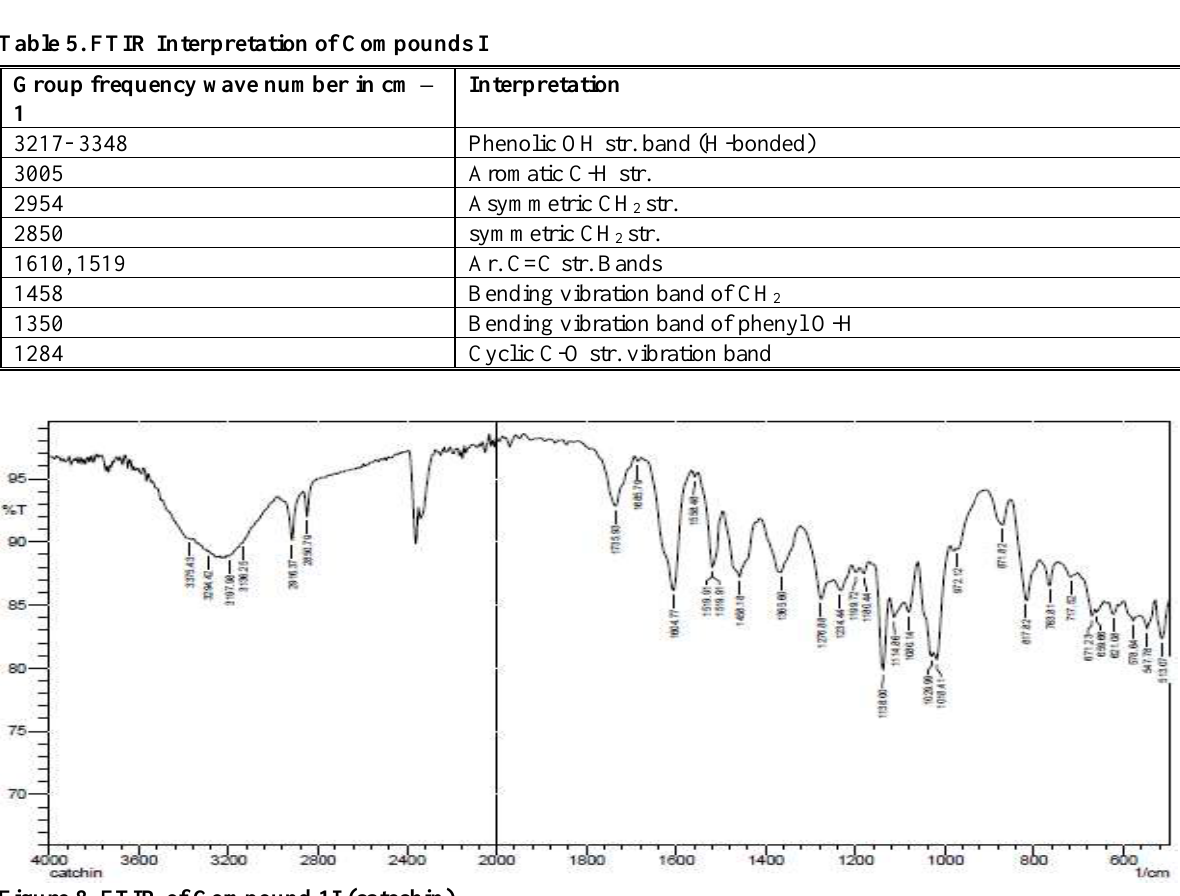
Figure 8. FTIR of Compound 1I